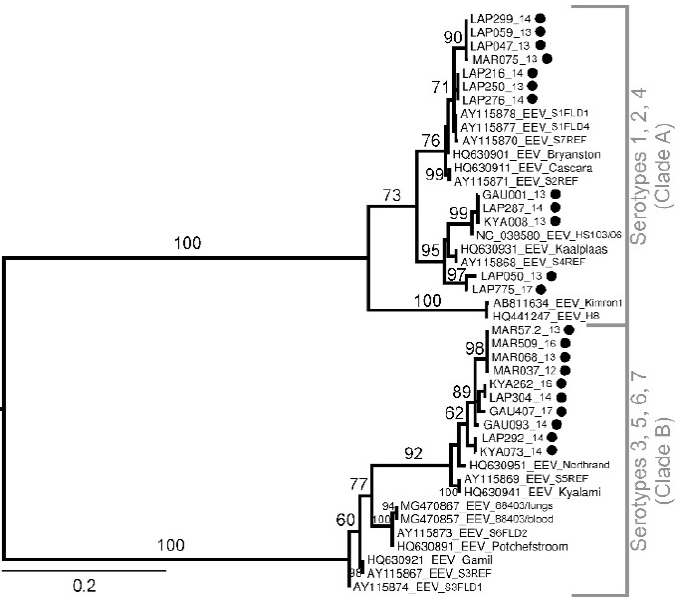
Figure 4. Maximum likelihood phylogram based on the partial (nucleotides = 401, 43 taxa) EEV NS3 segment. Bootstrap support calculated using autoMRE function invoked in RAxML (GTR + G model). Phylogram rooted at midpoint. Filled black circles indicate new sequences.